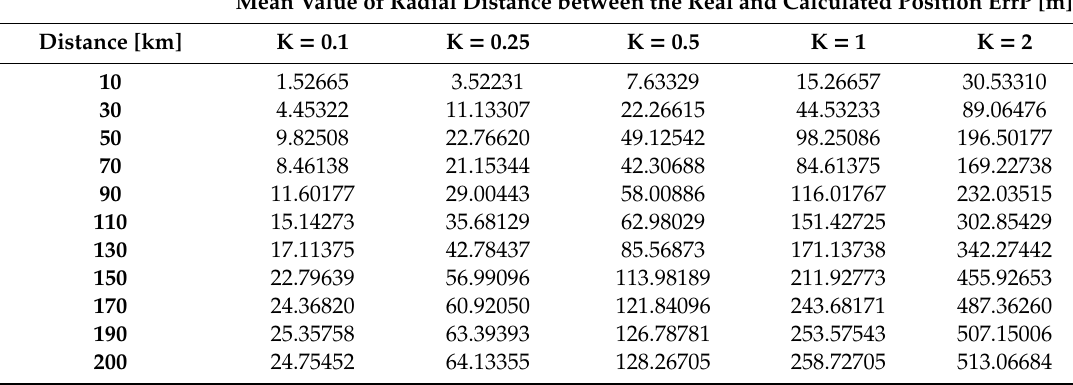
Table 2. The results from the simulation with the pseudo-range error.